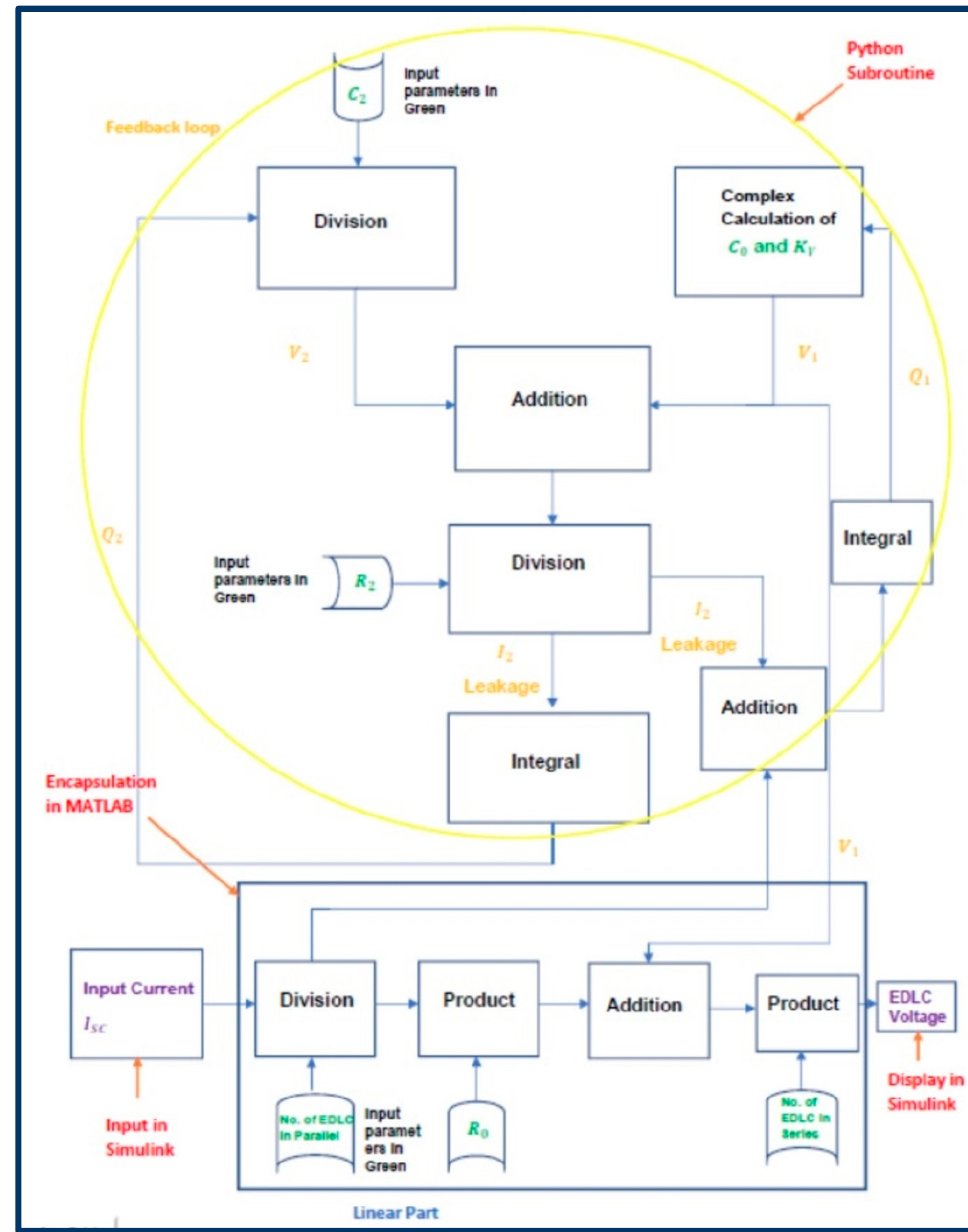
Figure 4. Python/MATLAB/Simulink (PMS) flow chart.